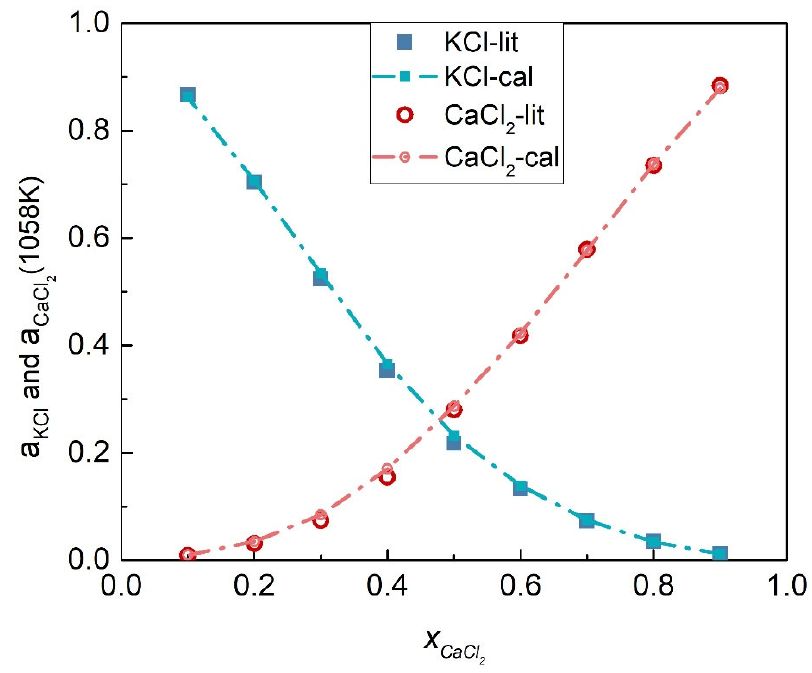
Figure 12. Comparison of the calculated activities and literature data of each element of the KCl-CaCl 2 system (1058 K).